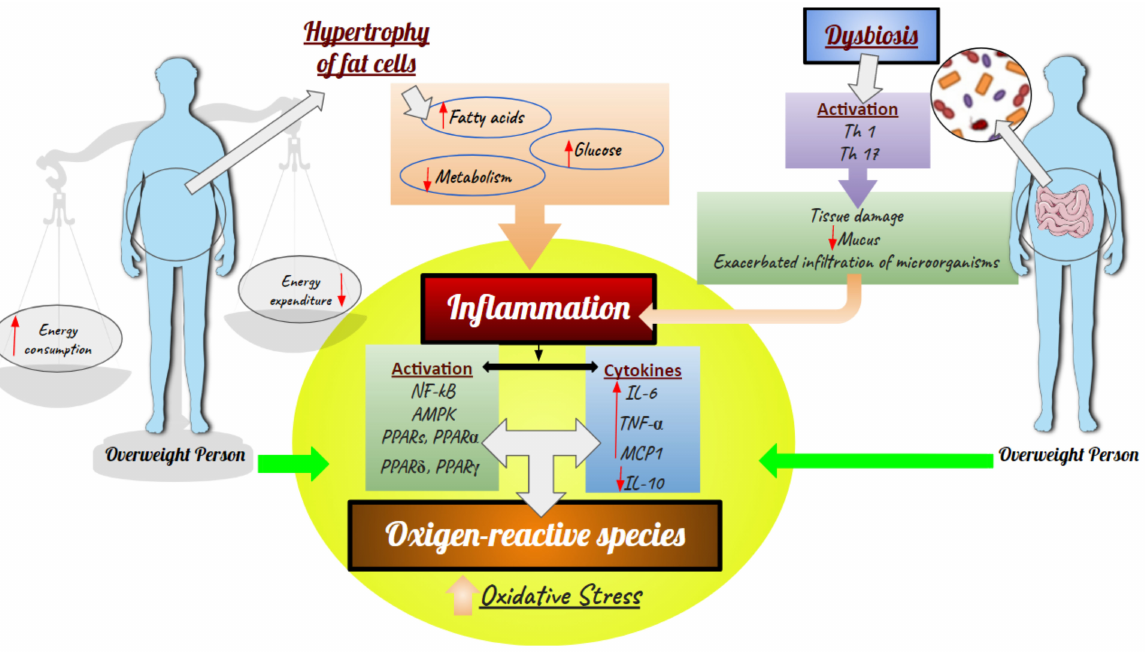
Figure 3. Effects of body fat buildup and dysbiosis in the inflammatory process and oxidative stress. NF- κ B, AMPD–AMP-activated protein kinase, PPARs, IL-6, TNF- α , MCP1, IL-10, Th-lymphocytes